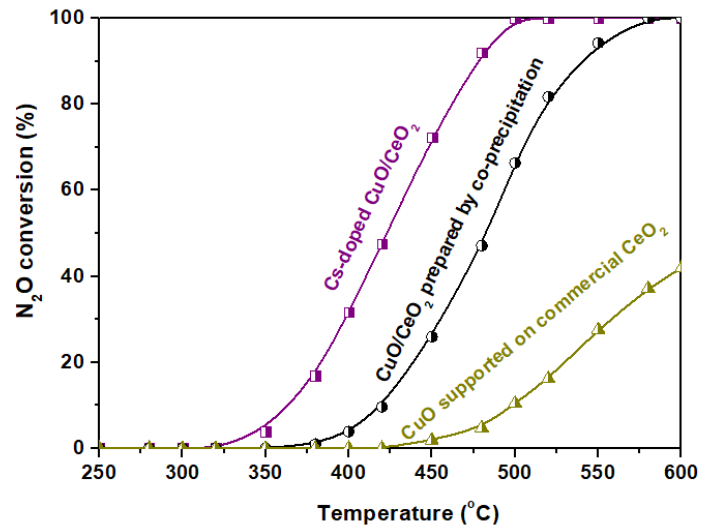
Figure 15. Optimization of deN 2 O performance of CuO/CeO 2 mixed oxides by co-adjusting synthesis parameters (co-precipitation method) and electronic state (alkali addition). For comparison, the corresponding performance of CuO supported on commercial ceria is included. Reaction conditions: 0.1% N 2 O balanced with He; WHSV = 90,000 mL g −1 h −1 . Adapted from Ref. [166]. Copyright© 2018, Royal Society of Chemistry.